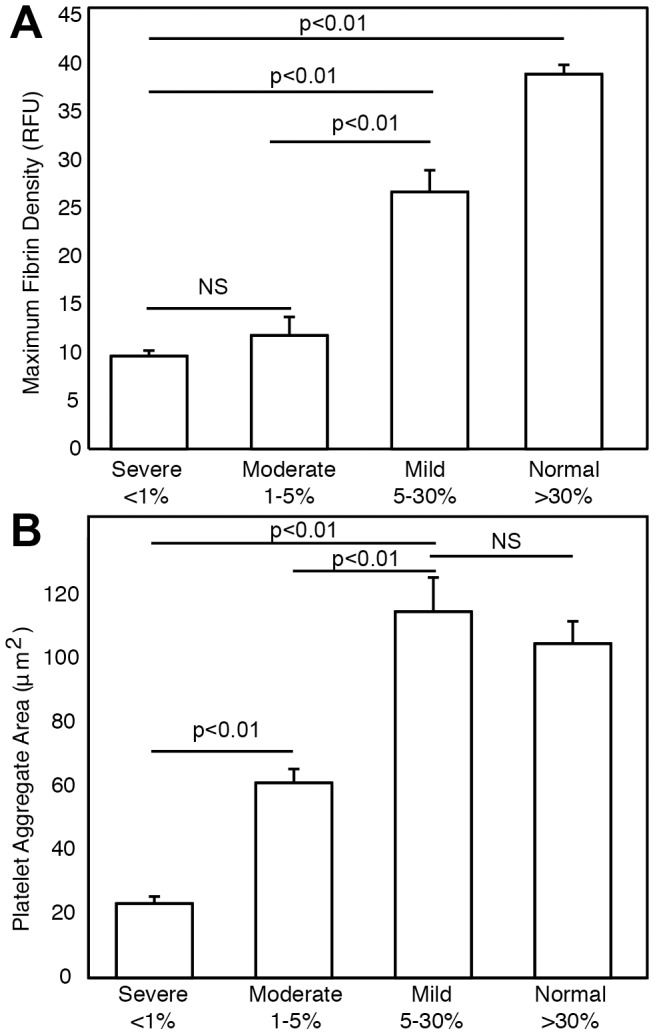
Fibrin density and platelet aggregate size for different clinical categories of hemophilia A.(A) Maximum fibrin density and (B) platelet aggregate area for severe, moderate and mild FVIII deficiencies compared to normal controls. Error bars represent standard error. Lines indicate comparisons between pairs according to Tukey's honestly significantly difference test following Kruskal-Wallis ANOVA. NS indicates not significant.